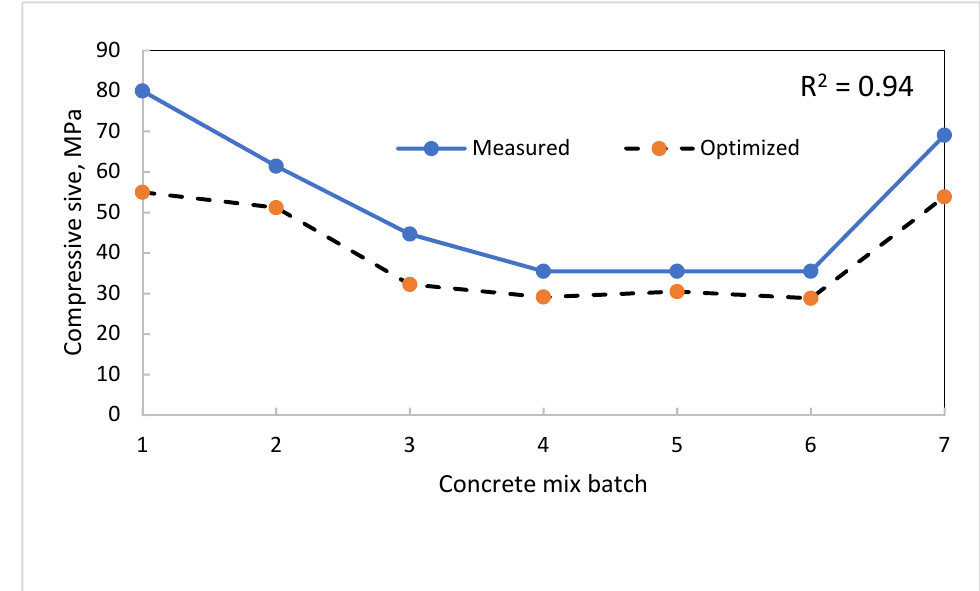
Figure 9. Optimised Embodied Carbon relation with measured compressive strength.